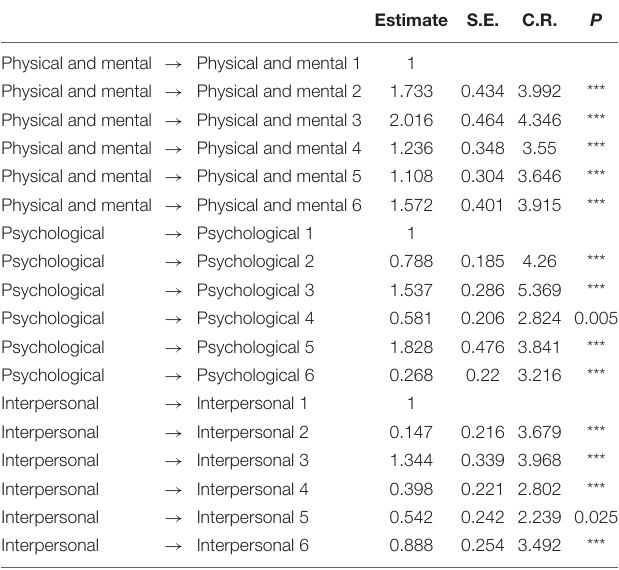
TABLE 4 | Confirmatory factor analysis table.